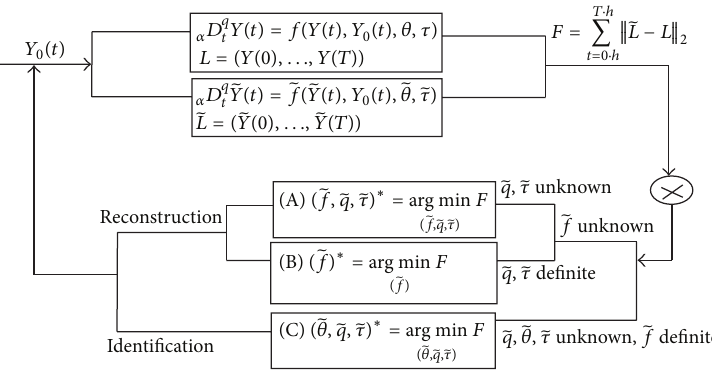
Figure 1: Gao’s mathematical model for fractional chaos